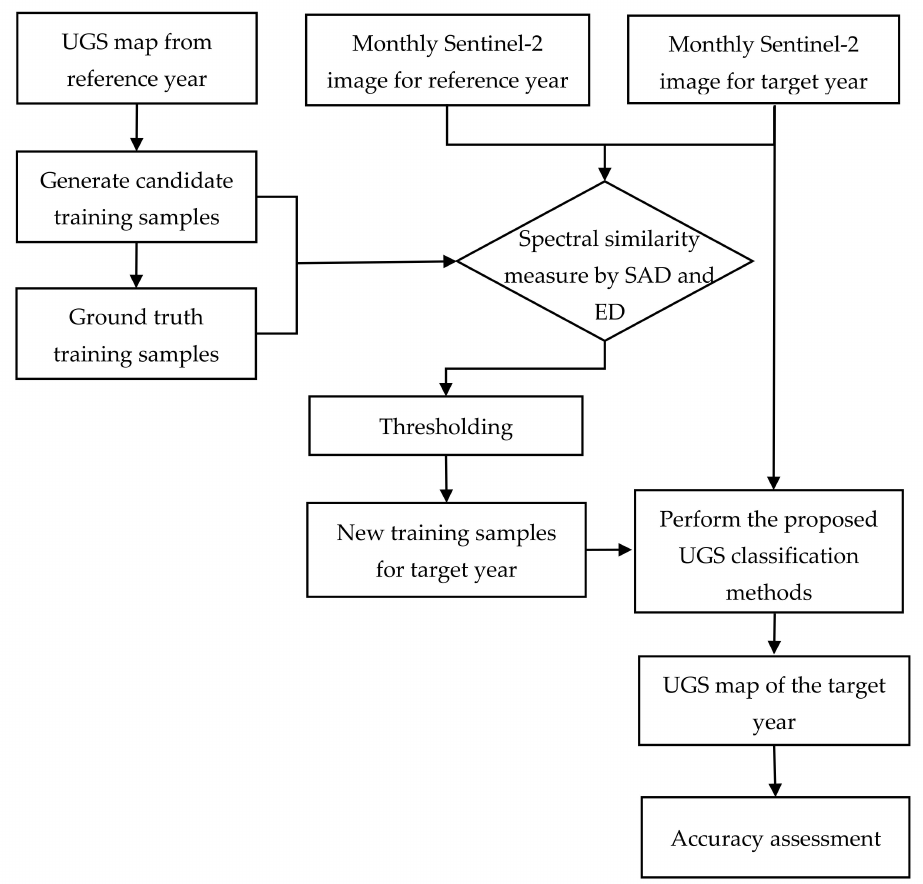
Figure 3. Flowchart to produce up-to-date UGS maps for any target